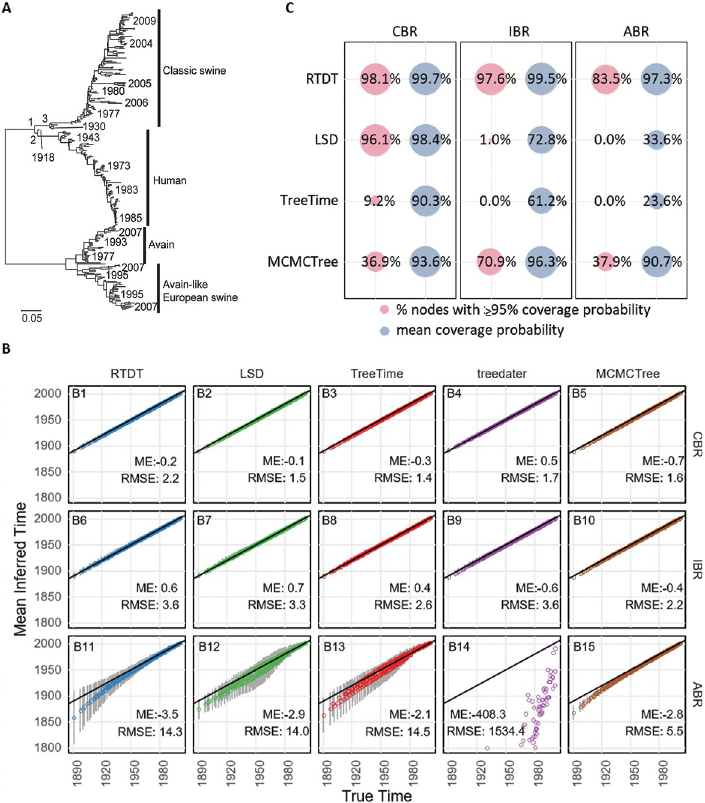
Fig 5. Performance of methods on the ladder-like tree. (A) Phylogeny of Influenza A strains. Sampling times are given for some tips. A number along a node is a node ID, which corresponds to those in Table 1. Fifty datasets were generated along this phylogeny with CBR, IBR or ABR. (B) Average node time estimates by RTDT (blue), LSD (green), TreeTime (red), treedater (purple), and MCMCTree (brown) for datasets with CBR, IBR, and ABR. Each time point is an average of 50 simulated datasets, and error bars indicate standard deviations. Error bars of treedater are not shown for ABR datasets, because these standard deviations were very large. MCMCTree was performed by using the correct branch rate model for each dataset. Mean error (ME) and root mean square error (RMSE) are shown within each panel. (C) The proportion of nodes with � 95% coverage probabilities and mean of coverage probabilities of CIs or HPDs. The proportion of nodes with � 95% coverage probability is the proportion of nodes in which � 95% of CIs and HPDs contained the actual times, and mean coverage probability is the mean proportion of CIs and HPDs that contained the actual time across the nodes. We did not use treedater because it does not produce